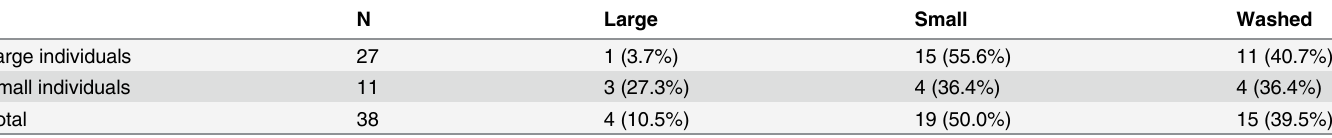
The plant sizes were categorized as follows: large individuals ( (cid:3) 150 culms) and small individuals ( < 150 culms). Large individuals become small when partly torn off by fl oods. Small individuals become large when they grow a suf fi cient number of culms. The loss by fl oods is indicated as washed (out). Parentheses indicate the percentage. Dates I – II are shown in the text.